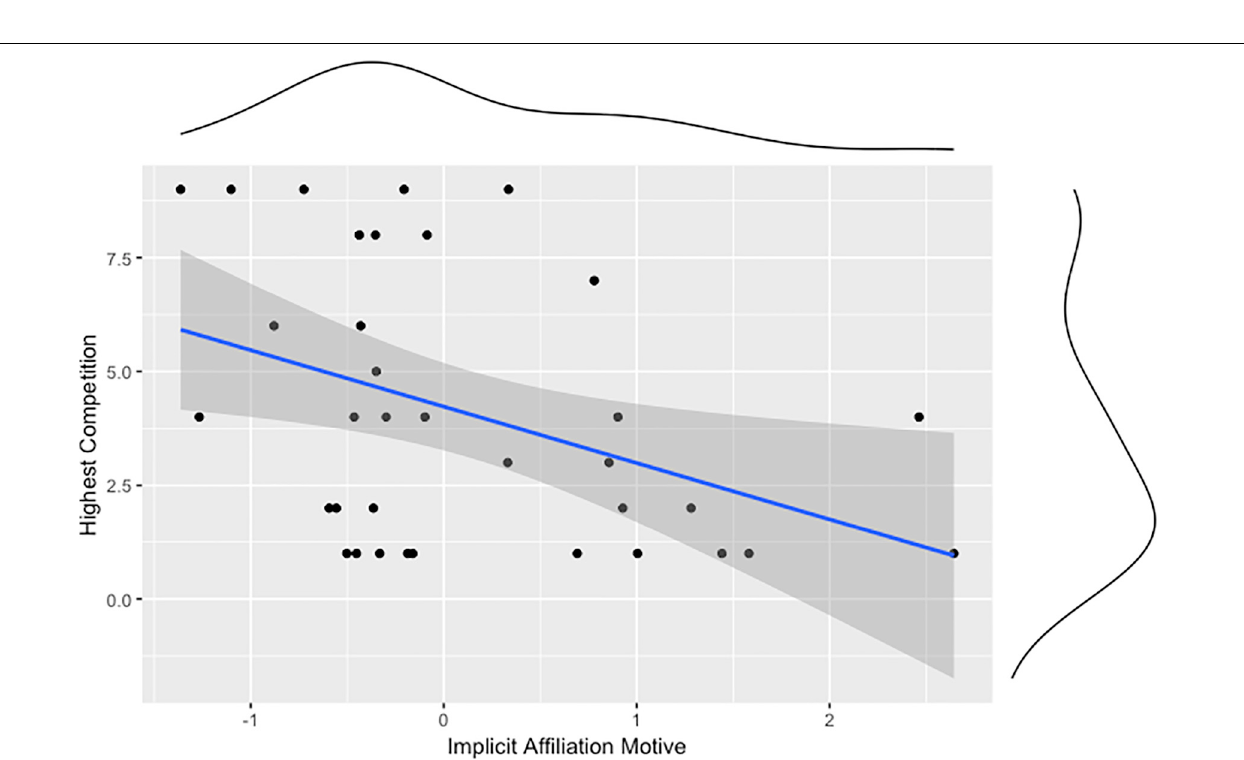
FIGURE 4 | Association between the implicit affiliation motive and the highest competition gymnasts participated in.